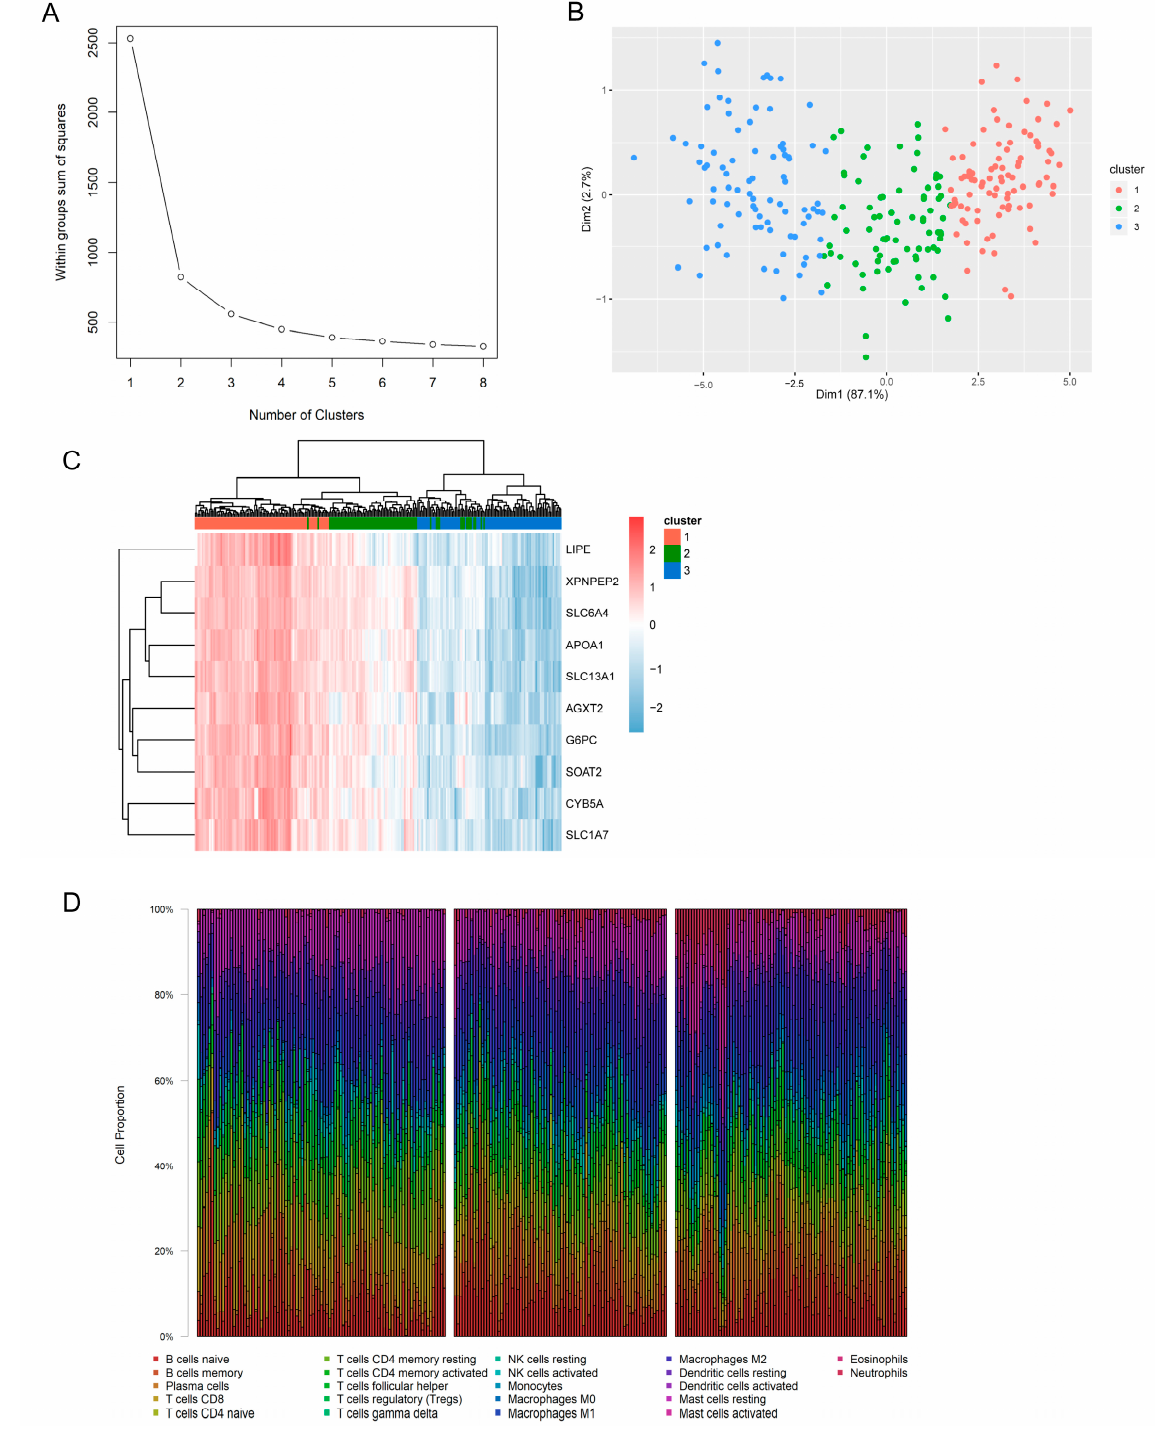
Figure 5. Identification of pediatric CD subtypes. ( A ). Identification of optimal number of clus- ters with non-supervised K-means clustering method. The within group sum of squares ( y -axis) decreases with the increment of clusters number ( x -axis). The optimal clustering was at the number of 3. ( B ). Clustering of 254 treat-naïve pediatric CD patients based on 10 hub genes. ( C ). Heatmap of 10 hub genes expression in three new subclasses of pediatric CD. ( D ). Infiltration profile of 22 immune cells in three newly proposed molecular subtypes of pediatric CD. CD, Crohn’s disease; SSE, sum of the squared